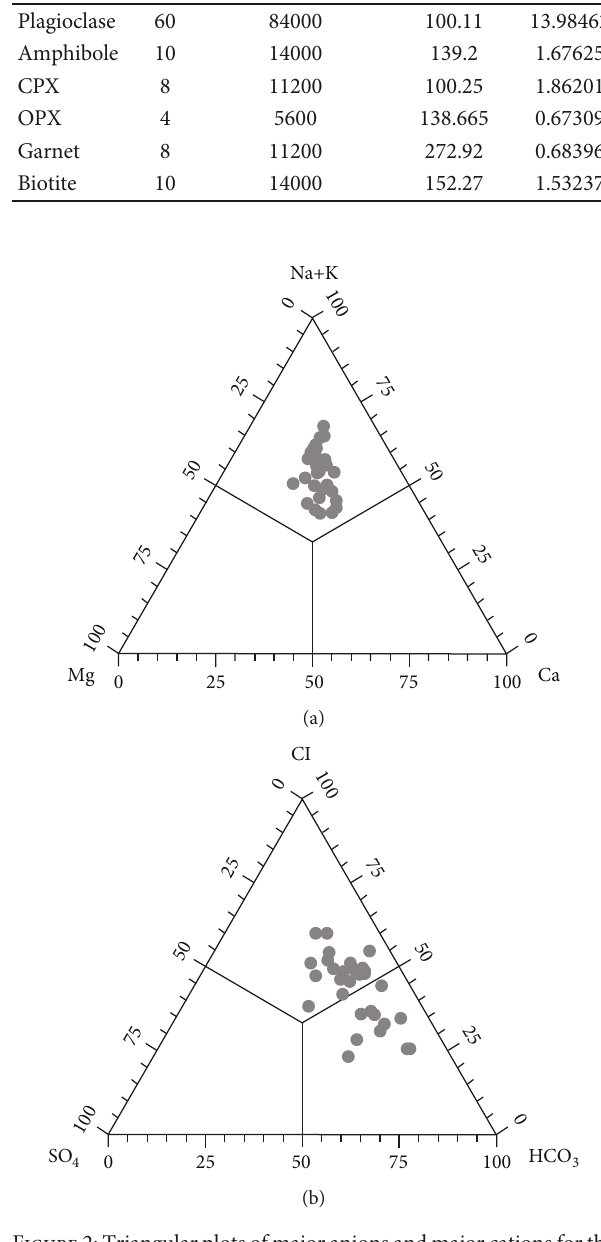
Figure 2: Triangular plots of major anions and major cations for the 30 groundwater samples from the study